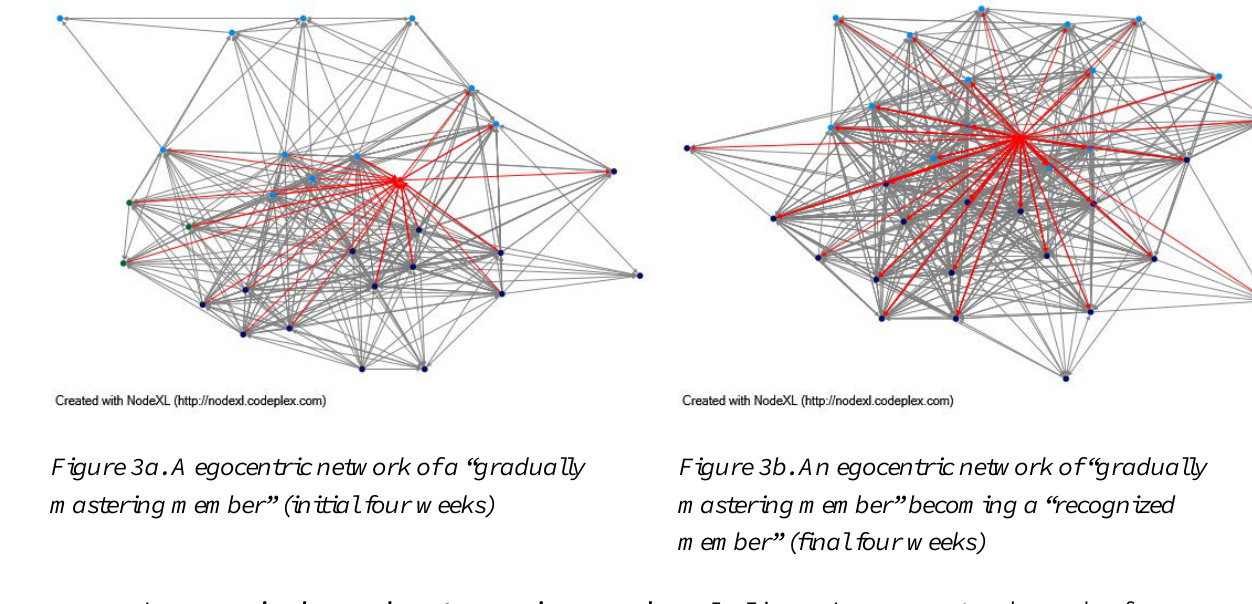
Figure 4b. An egocentric network of a recognized member becoming a “passive member” (final four weeks)